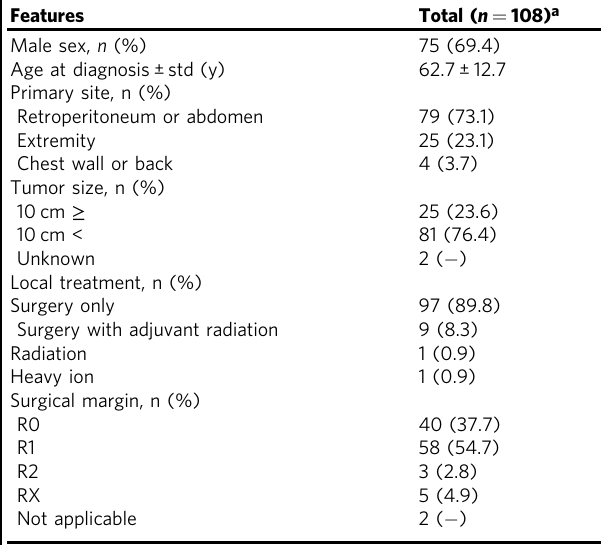
Table 1 Clinical characteristics of patients with